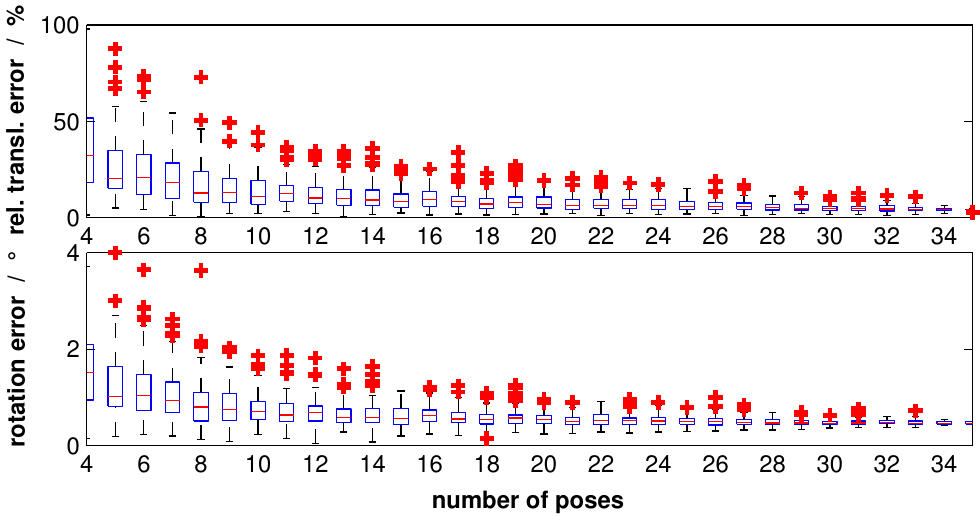
Figure 9. Error analysis of the simulated calibration for each number of